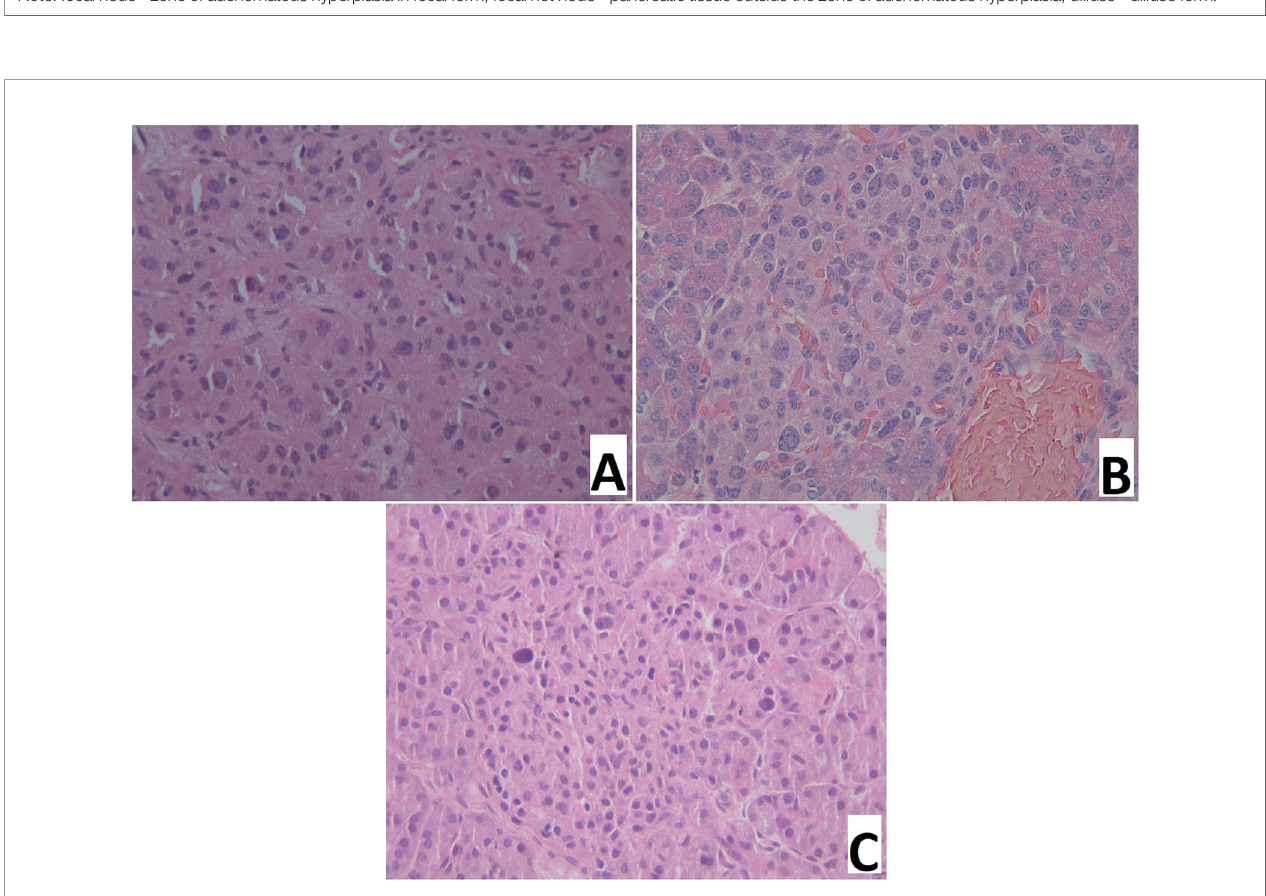
FIGURE 5 | Pancreatic paraf fi n sections of patients with congenital hyperinsulinism. (A) – focal form, a site of adenomatous hyperplasia with hypertrophied endocrinocyte nuclei. (B) – diffuse form, an islet of Langerhans with hypertrophied endocrinocyte nuclei. (C) – atypical form, islet of Langerhans with hypertrophied nuclei of endocrinocytes. Hematoxylin and eosin staining, x